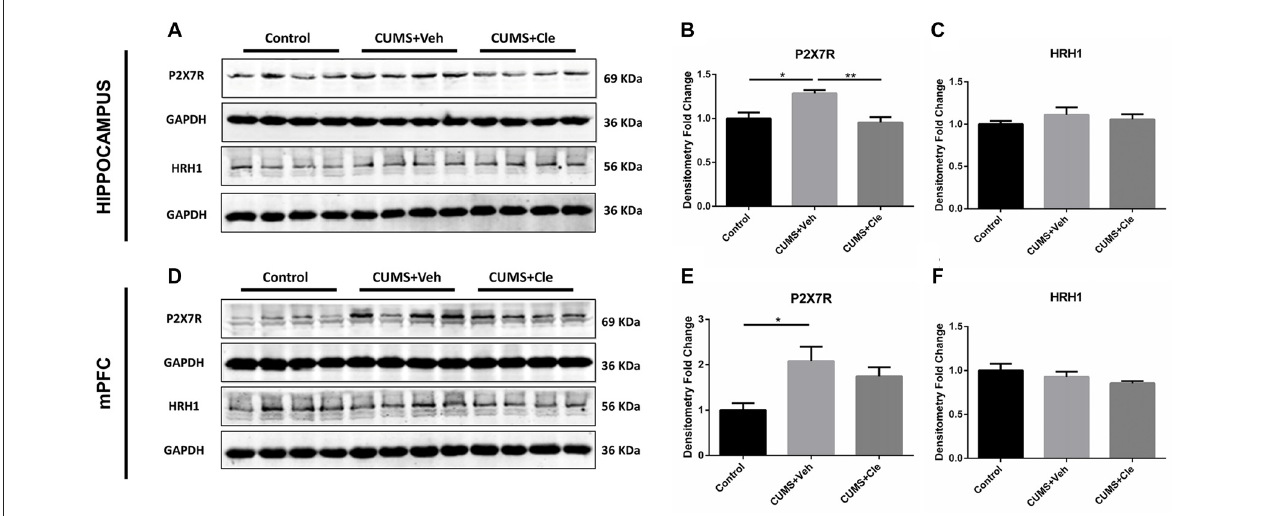
FIGURE 5 | Detection of P2X7 receptor and histamine receptor H1 (HRH1) in hippocampus and mPFC. (A–F) CUMS treatment upregulated the protein expression of the purinergic receptor P2X, ligand-gated ion channel 7 (P2X7R) in both hippocampus and mPFC subregions. In the meantime, continuous intraperitoneal administration of clemastine protected mice from stress-induced upregulation of P2X7R in the hippocampus rather than mPFC. There is no statistical alteration of HRH1 expression in both subfields of hippocampus and mPFC, even when the mice were subjected to stress stimulation or clemastine injection ( n = 4 for (A–F) , ∗ p < 0.05, ∗∗ p <